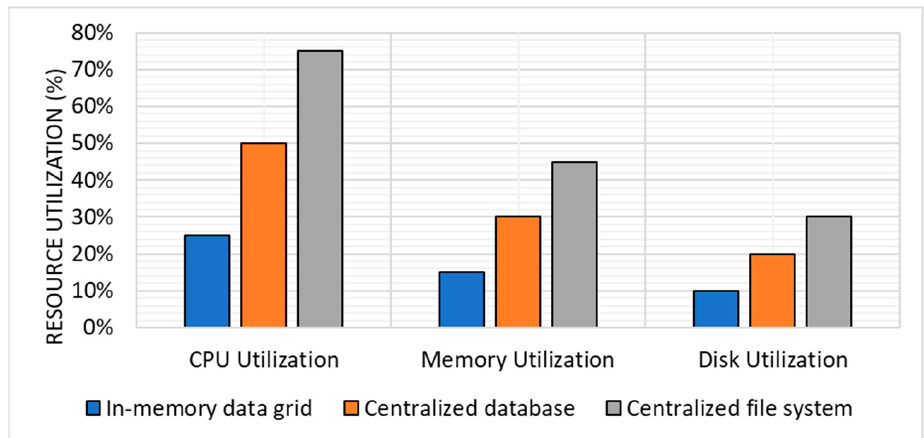
Figure 3. The average of Scheduling for resource utilization.